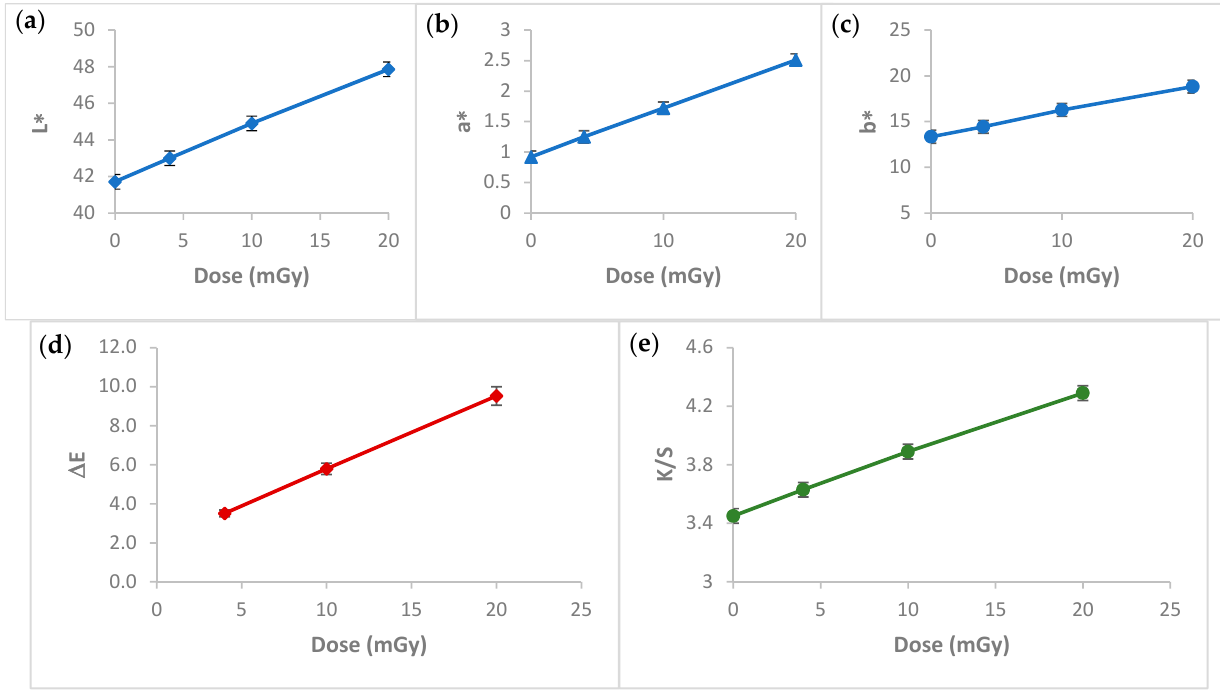
Figure 8. Hunter’s color parameters: ( a ) lightness L*, ( b ) redness-greenness axis a*, ( c ) yellowness-blueness axis b*, ( d ) total color difference Δ E and ( e ) color strength K/S values for PVA/NBT films irradiated from 4 to 20 mGy.